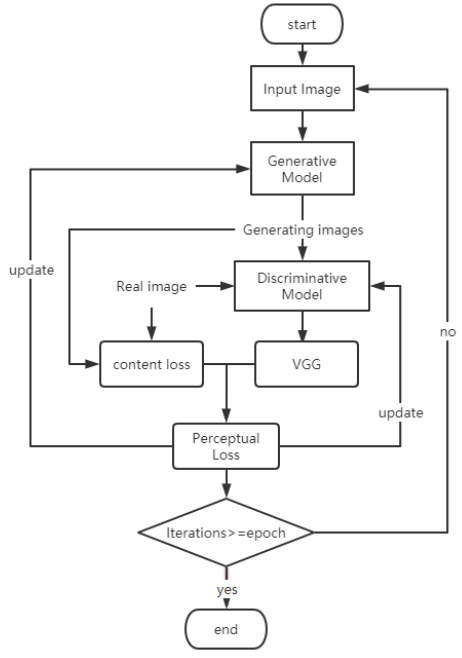
Figure 1. Overall Network Architecture.